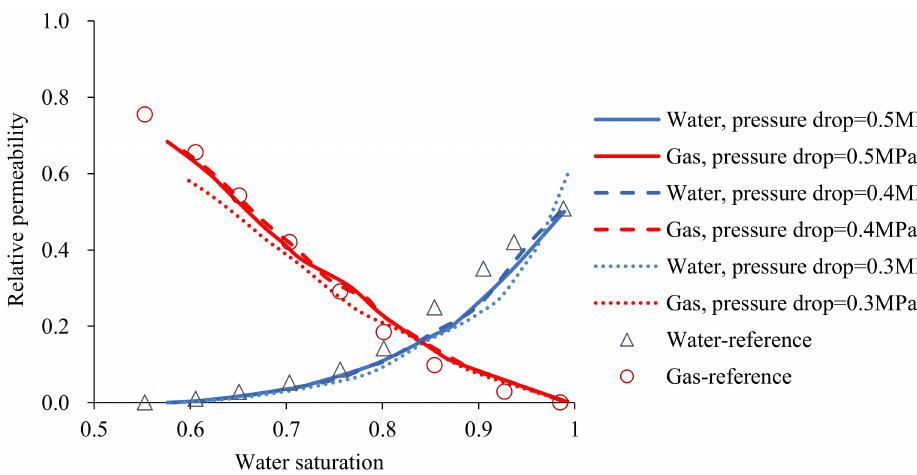
Figure 14. Effects of varying factors on the interpretation results of the JBN